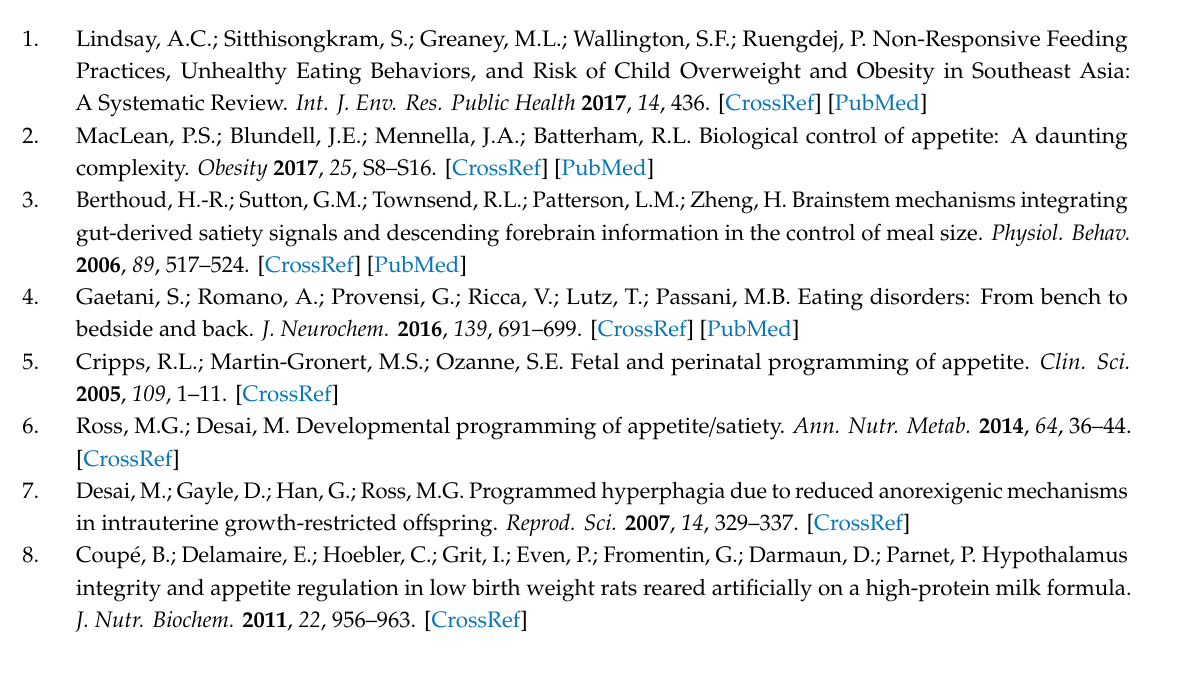
Figure S1: Postnatal growth of suckling rats in the di ff erent groups of OS supplementation, Table S1: Primer sequences, Figure S2: Growth of weaned rats until adulthood, Figure S3: Relative expression of gene implied in the endocrine lineage and in L-cells di ff erentiation in the colon. Figure S4: Supplemental parameters of meal pattern. Figure S5: Hierarchical clustering of phylogenetically informed distance matrix computed using the unweighted UniFrac metric for cecal contents collected at PND 124 / 126. Table S2: Concentration of SCFA in ileal and cecal contents at PND 124 /